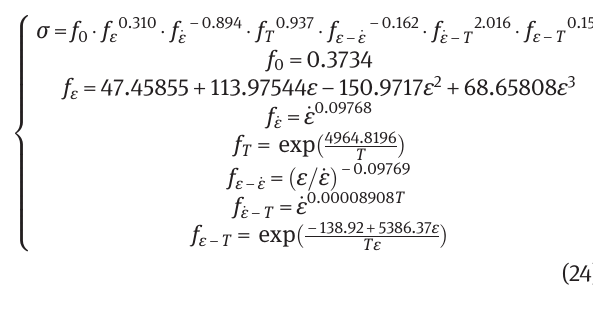
correction coefficient f 0 and the converged weights